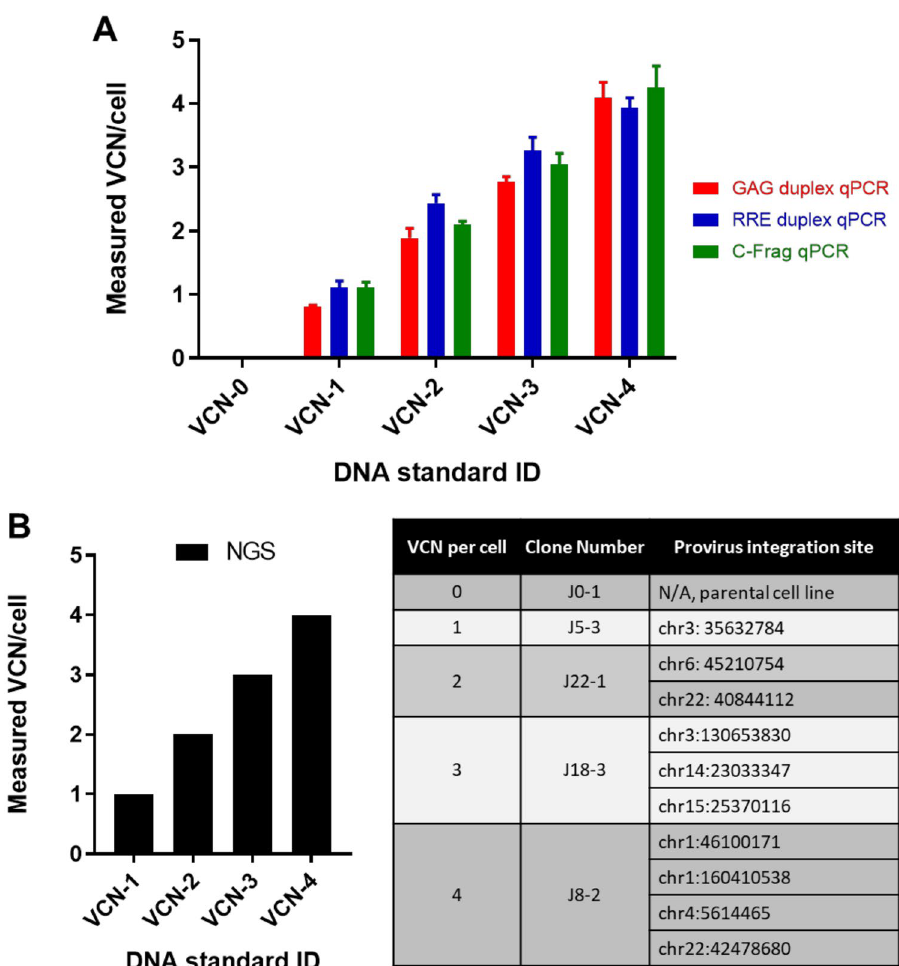
Figure 2. VCN reference standards characterization by qPCR and NGS. Genomic DNA extracted from clonally selected Jurkat cell lines was used to perform vector copy number analysis using three distinct qPCR assays and NGS. A) qPCR analysis was carried out using 200 ng of genomic DNA per reaction and three separate assays with primers/probe sets targeting three distinct sequences within the integrated vector sequence. GAG’ and RRE specific assays were designed and optimized as duplex assays with simultaneously run internal reference. C-frag qPCR was run as a single assay and then results were normalized to results from separately run qPCR for a reference gene. The graph represents a mean from at least two independent experiments where each reaction was run in triplicate. Error bars represent standard deviations for the means of the data sets. B) Next generation sequencing was performed on selected clones and confirmed presence of the entire proviral sequence integrated into the Jurkat cell genome which was consistent with expected VCN per cell for each clone. NGS mapped provirus integration sites and the identified insertion sites were validated using PCR and Sanger sequencing primers designed based on the flanking sequences of the mapped integration